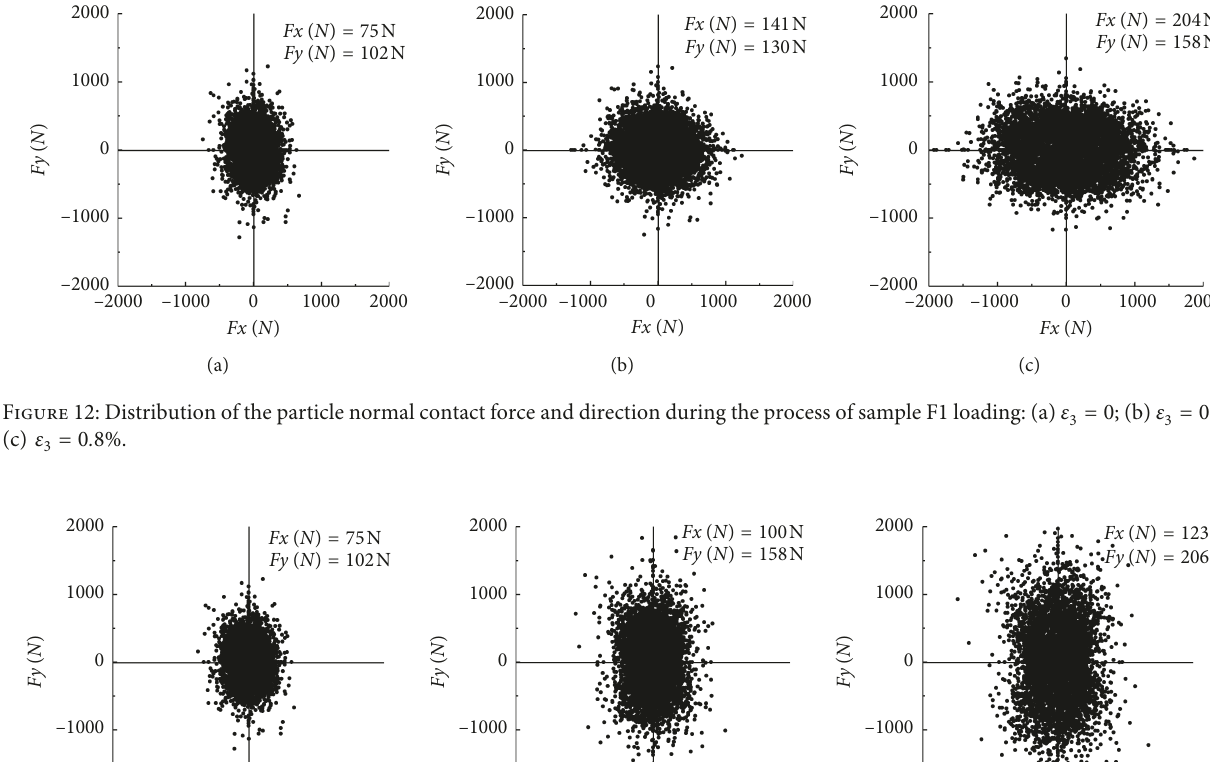
. 4%; 1 (cid:30) 0; (b) ε 1 (cid:30) 0